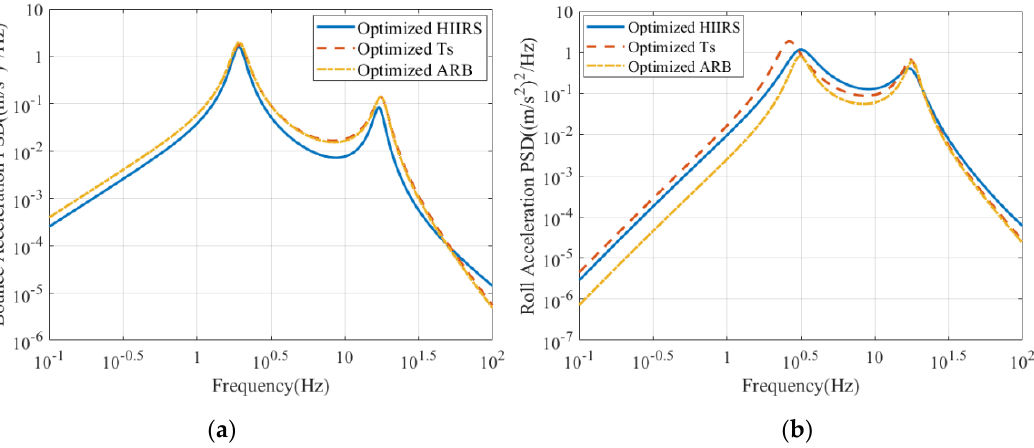
Figure 6. The optimization results with the ride comfort as the single objective, ( a ) the body bounce acceleration PSD; ( b ) the body roll acceleration PSD.